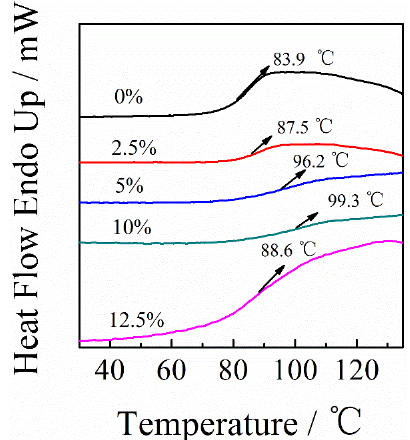
Figure 7. Differential scanning calorimeter (DSC) analysis curves of PAI/PANI/CB ternary composites with different weight ratios of CB.